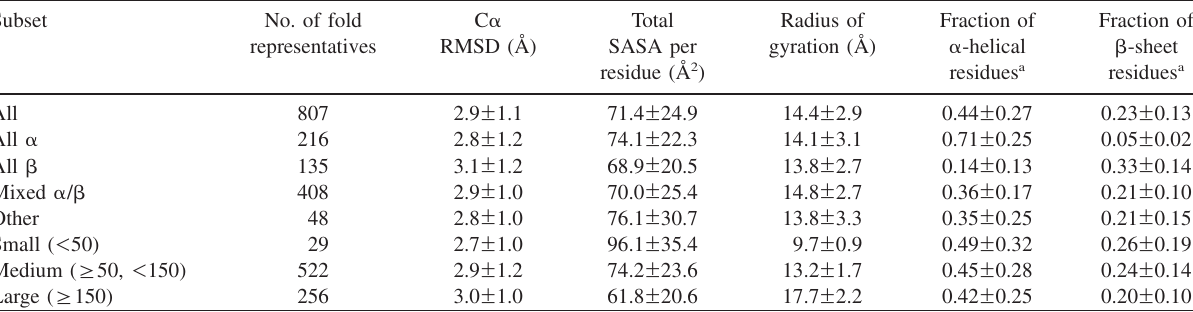
Table 1 Average properties of native state simulations grouped by structural class and size. Subset No. of fold C a Total Radius of Fraction of Fraction